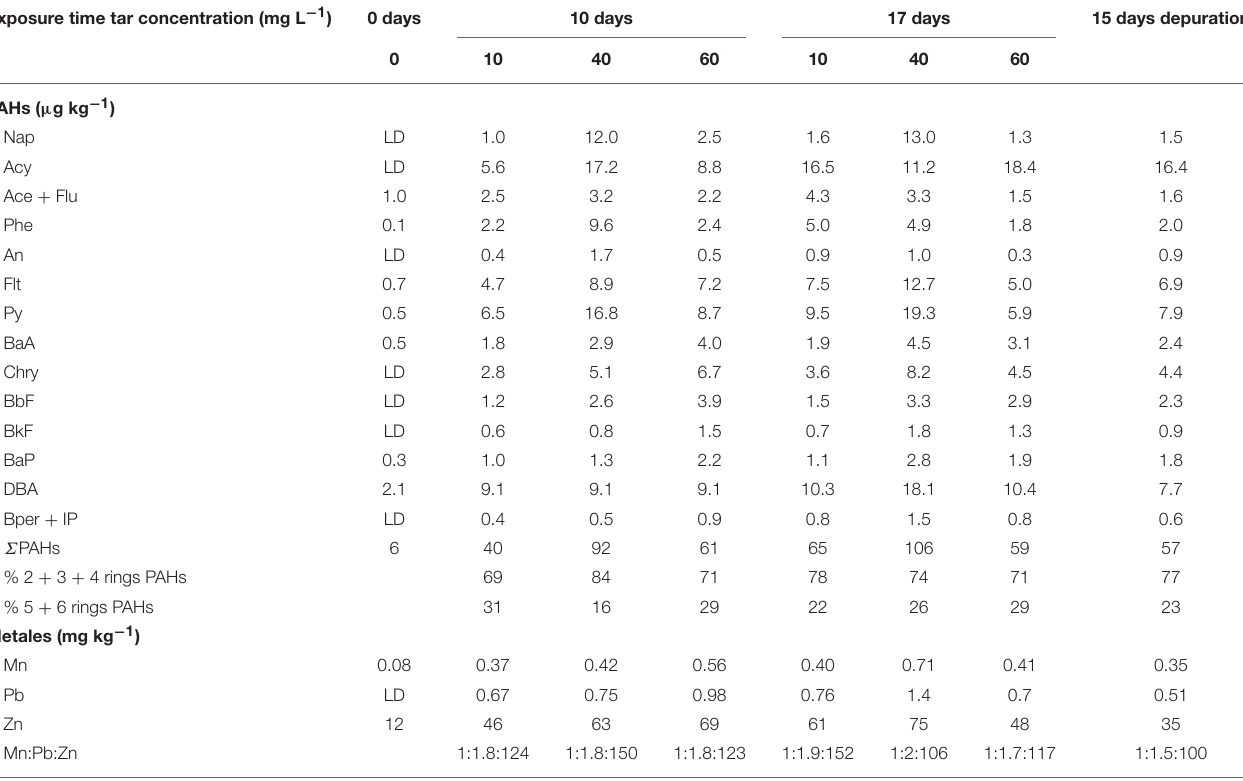
TABLE 1 | Accumulation of hydrocarbons, Mn, Pb, and Zn in Mytilus galloprovincialis exposed to different tar concentrations and exposure times. Exposure time tar concentration (mg L − 1 ) 0